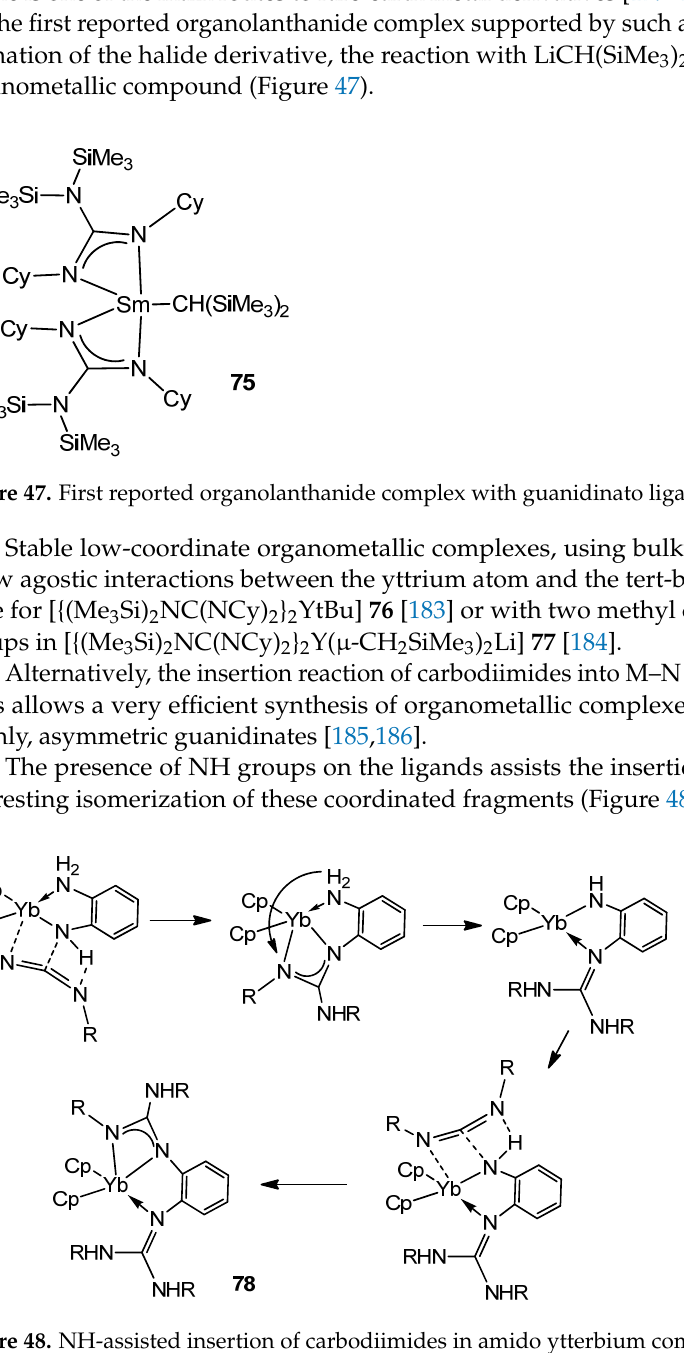
Figure 46. Phosphorescent carbene copper guanidinato compound.